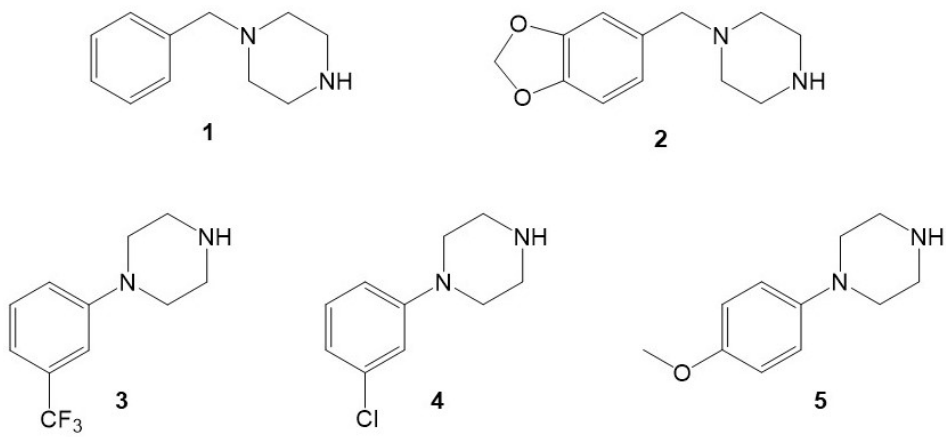
Figure 1. Chemical structures of benzylpiperazine ( 1 ) and its related analogues 1-(3,4-methylenedi- oxyphenyl)piperazine ( 2 ), 1-(3-trifluoromethylphenyl)piperazine ( 3 ), 1-(3-chlorophenyl)piperazine ( 4 ) and 1-(4-methoxyphenyl)piperazine ( 5